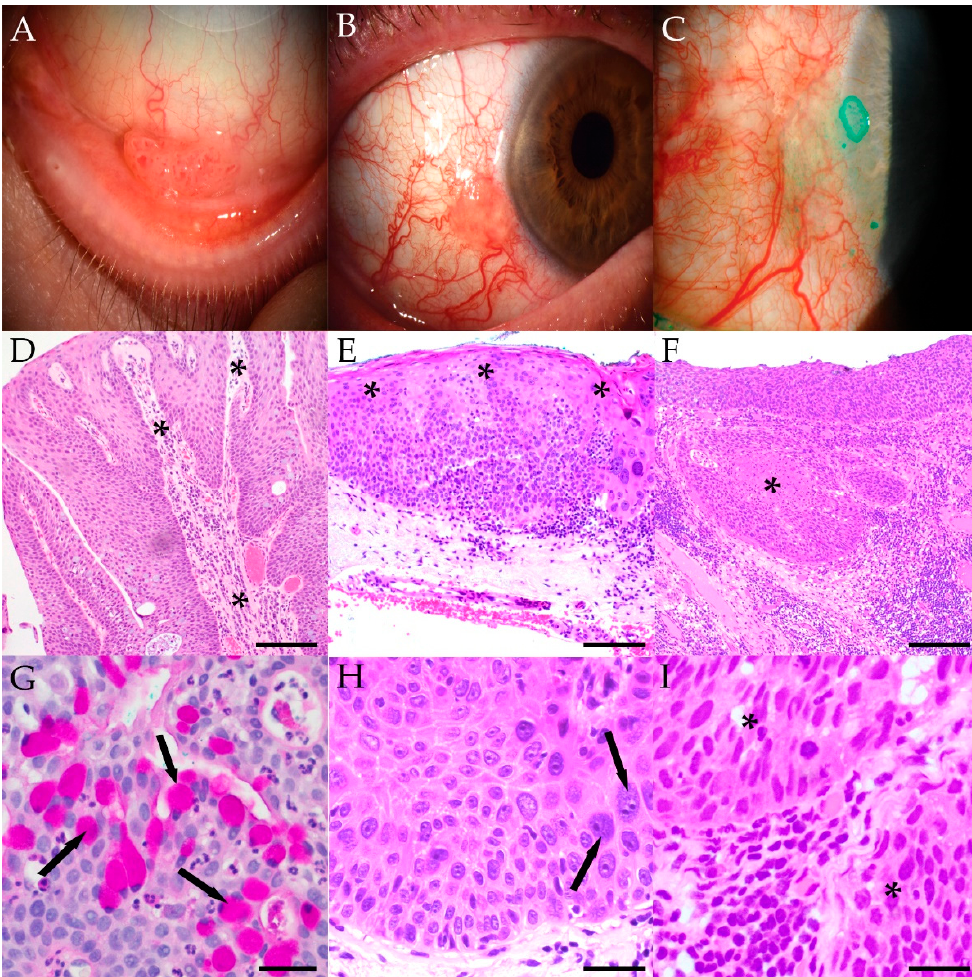
Figure 1. Clinical appearance of squamous bulbar conjunctival lesions including a lobulated papil- loma extending toward the inferior fornix from Case 3 ( A ), a more nodular CIN encroaching on the limbus from Case 39 ( B ), and a larger invasive perilimbal SCC with prominent conjunctival hyperemia from Case 51 ( C ). Representative low-magnification histology of conjunctival lesions including a papilloma characterized by hyperplastic epithelium overlying fibrovascular core denoted with asterisks ( D ) (scale bar: 100 μ M), a CIN exhibiting a thickened and dysplastic epithelium (asterisks) ( E ) (scale bar: 50 μ M), and an invasive SCC with neoplastic cells breaching the epithelial basement membrane and infiltrating the substantia propria (asterisk) ( F ) (scale bar: 100 μ M). Higher magnifi- cation of a representative conjunctival papilloma with large numbers of PAS-positive goblet cells (arrows) and infiltrating neutrophils ( G ) (scale bar: 25 μ M), CIN with abnormal epithelial stratifica- tion and hyperchromatic and pleomorphic nuclei (arrows) ( H ) (scale bar: 25 μ M), and invasive SCC with epithelial dysplasia (asterisks) and intervening inflamed stroma ( I ) (scale bar: 25 μ M).